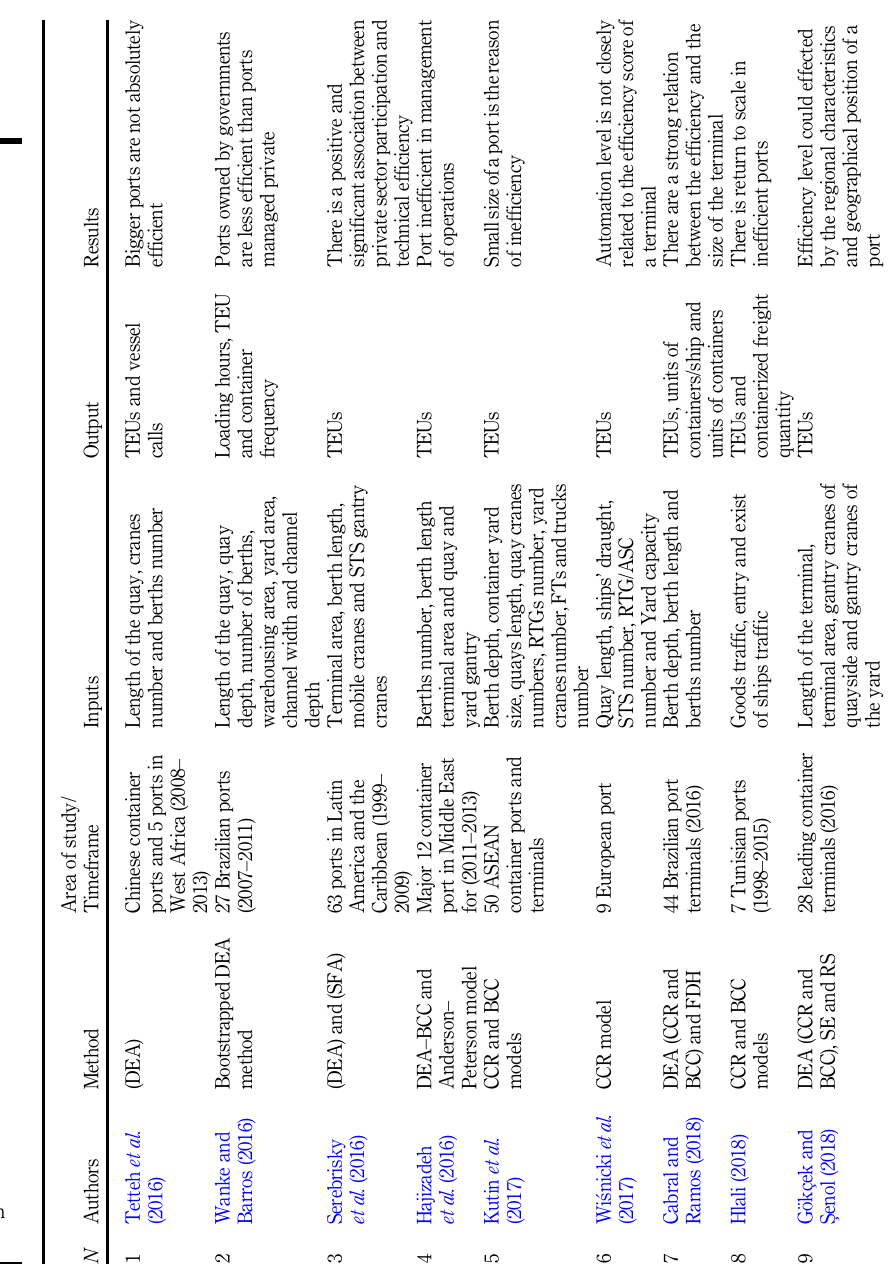
Table A1. Previous research